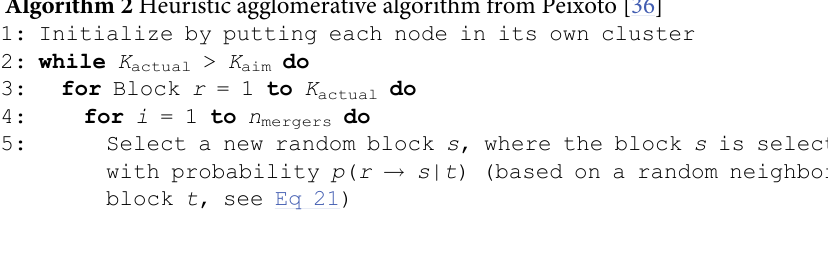
Algorithm 2 Heuristic agglomerative algorithm from Peixoto